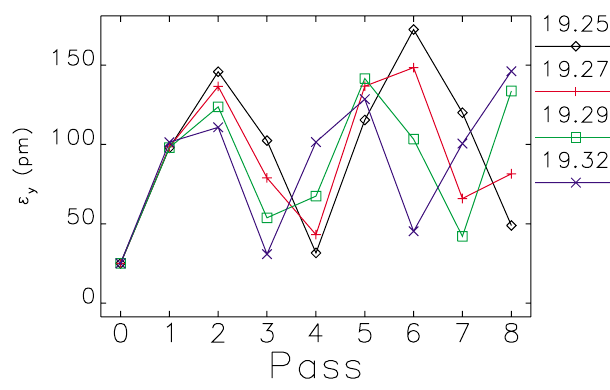
FIG. 7. (Color) Vertical emittance on successive passes in the ring for various vertical tunes, with 6 MV and h (cid:3) 8 . Interior sextupoles are